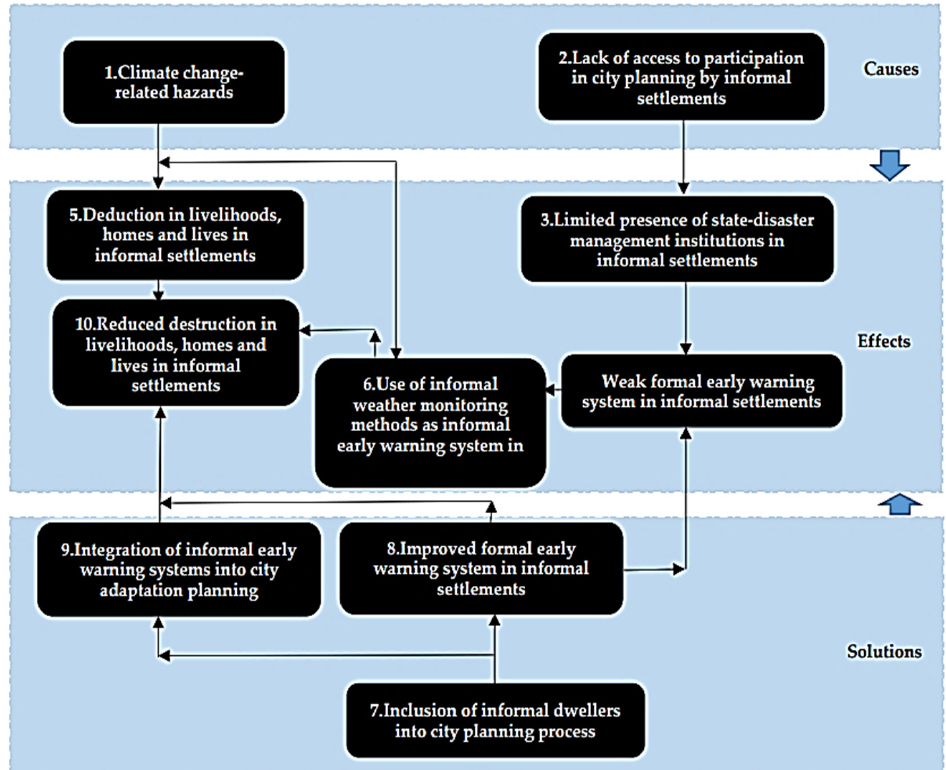
Figure 8. Improving hazard early warnings in informal settlements. Source: Authors’ construct